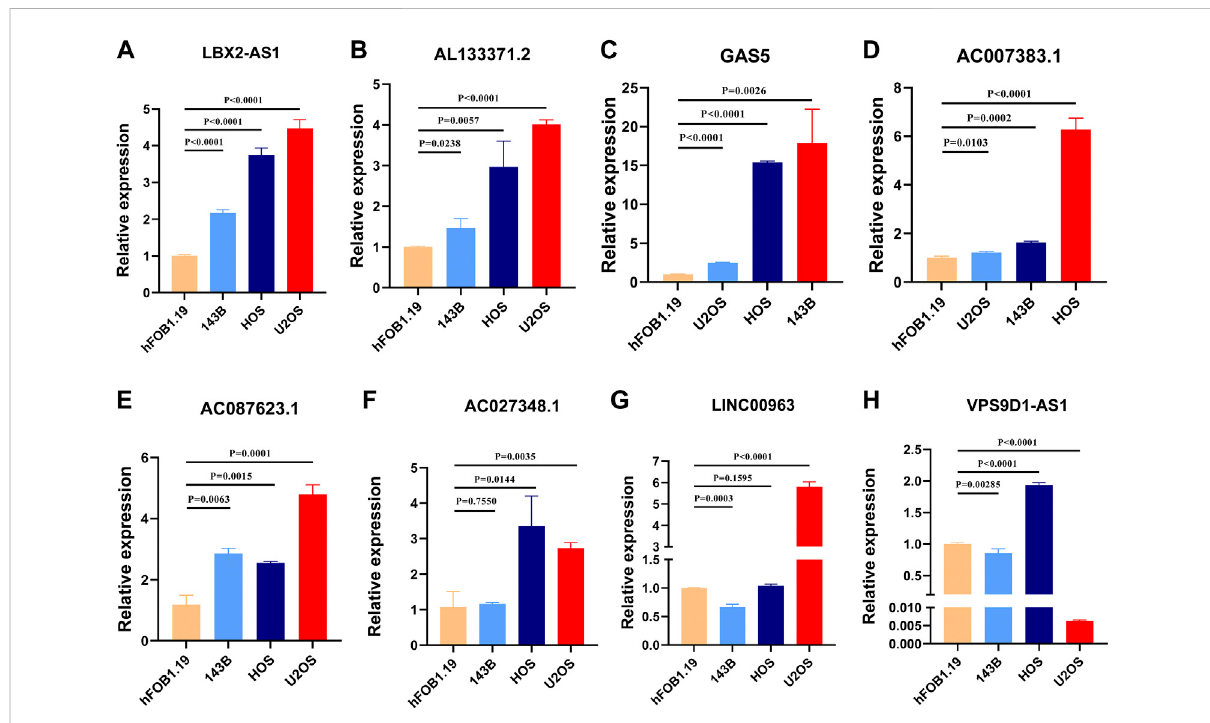
FIGURE 10 (A – H) . Validation of the expression of signature genes in OS cell lines. (A) . LBX2-AS1. (B) . AL133371.2. (C) . GAS5. (D) . AC007383.1. (E) . AC087623.1. (F) . AC027348.1. (G) . LINC00963. (H) .